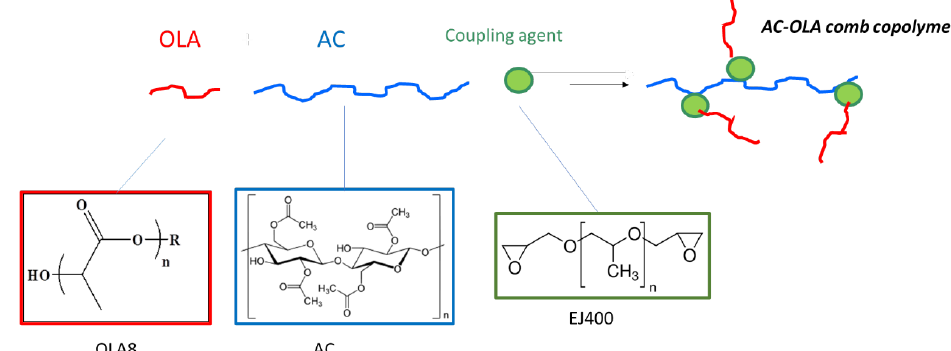
Figure 1. Strategy for the synthesis of AC-OLA comb copolymer by using a diepoxide (EJ 400) as coupling agent. In OLA8 formula n is in the range 3–15 and R- is derived from a high molecular weight linear alcohol.